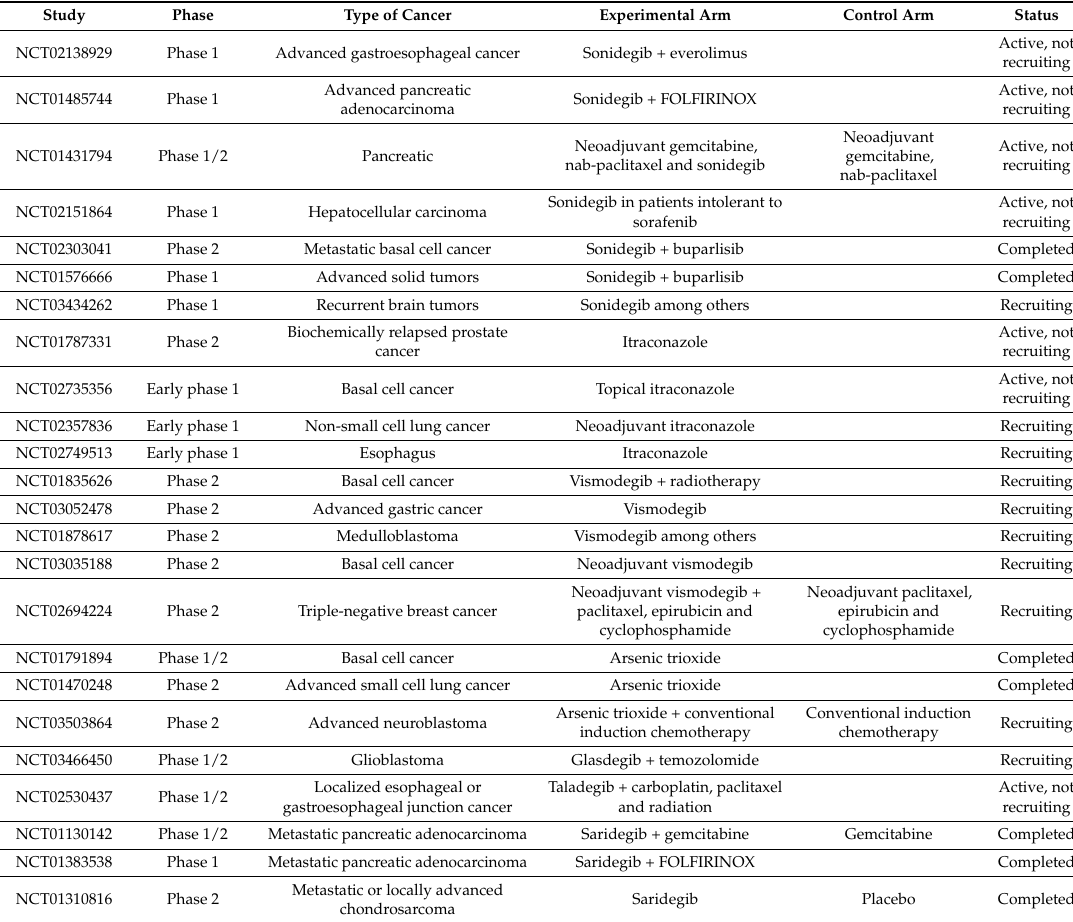
Table 2. HhP inhibitors that are being evaluated in clinical trials as of October 2018. Data from